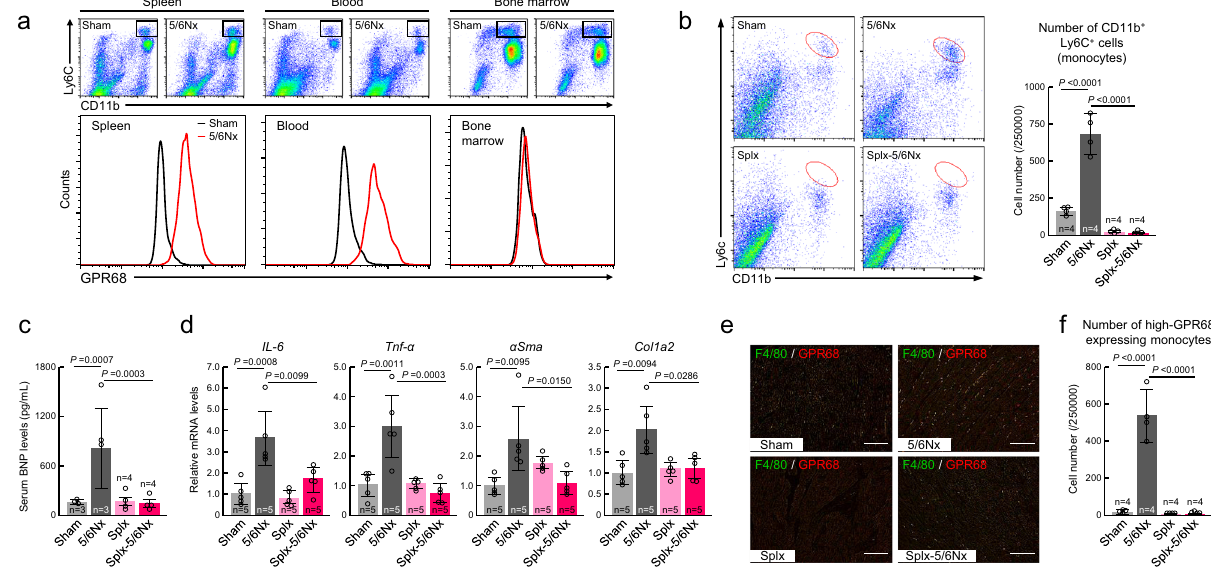
Fig. 3 Splenectomy reduces cardiac in fi ltration of monocytes and heart failure in 5/6Nx mice. a Induction of GPR68 expression in circulating monocytes in 5/6Nx mice. Flow cytometry analysis was performed to detect high-GPR68-expressing CD11b + /Ly6C + cells in the spleen, blood, and bone marrow of Sham and 5/6Nx mice. b Decrease in the number of cardiac-in fi ltrated CD11b + /Ly6C + cells in splenectomized (Splx)-5/6Nx mice. Left panel shows the fl ow cytometry histogram of CD11b + /Ly6C + cells isolated from the cardiac ventricle of Sham, 5/6Nx, Splx, and Splx-5/6Nx mice. The number of CD11b + /Ly6C + cells, indicated by red circles, was quanti fi ed and the data are shown in the right panel. c Serum concentrations of BNP in Sham, 5/6Nx, Splx, and Splx-5/6Nx mice. d The mRNA levels of in fl ammatory cytokines ( Tnf- α and IL-6 ) and fi brosis-related factors ( α Sma and Col1a2 ) in the cardiac ventricle of Sham, 5/6Nx, Splx, and Splx-5/6Nx mice. The mean value of the sham-operated wild-type group was set as 1.0. e Double immuno fl uorescence labeling of GPR68 with F4/80 in the ventricle slices prepared from Sham, 5/6Nx, Splx, and Splx-5/6Nx mice. High-GPR68-expressing cells are double-labeled (yellow) with F4/80. The scale bar indicates 50 μ m. f Decrease in the number of cardiac-in fi ltrated high-GPR68-expressing monocytes in Splx-5/6Nx mice. For all panels, graphs show the mean ± SD of individual mice in independent experiments. Statistical signi fi cance was determined using two-way ANOVA with Tukey – Kramer post hoc tests ( b – d , f ). Numbers and P -values are shown in each graph. Source data are provided as a Source Data fi